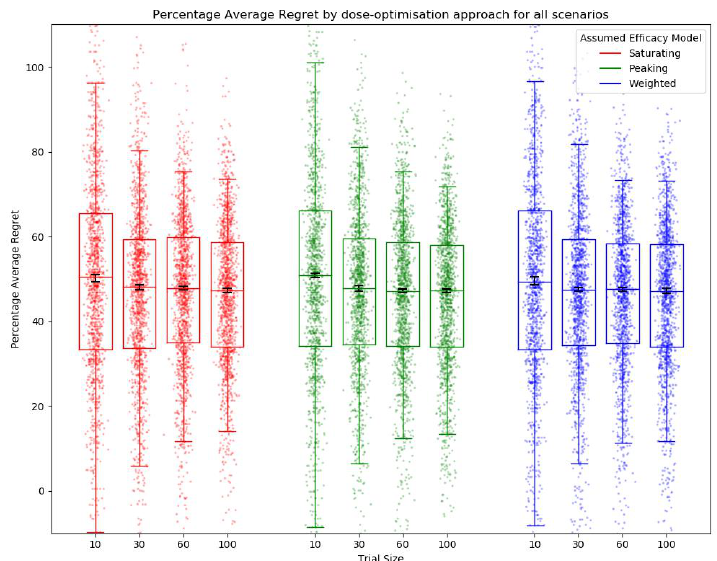
Figure 9. Percentage average regret for all scenarios by assumed efficacy model and trial size. Trial dose-selection method was full uniform exploration. Individual points represent percentage average regret for a single simulated clinical trial using that dose-optimisation approach for one of the 14 scenarios. The middle line of each boxplot is the median value; the box marks the 25th and 75th percentiles, and the whiskers mark the 5th and 95th percentiles of the data. Black lines represent the 95% confidence interval for the median of each distribution [47]. The majority of these distributions of PAR were not different to a statistically significant extent at the p = 0.05 threshold according to the Kolmogorov–Smirnov test. For further details on statistical significance, see Supplementary